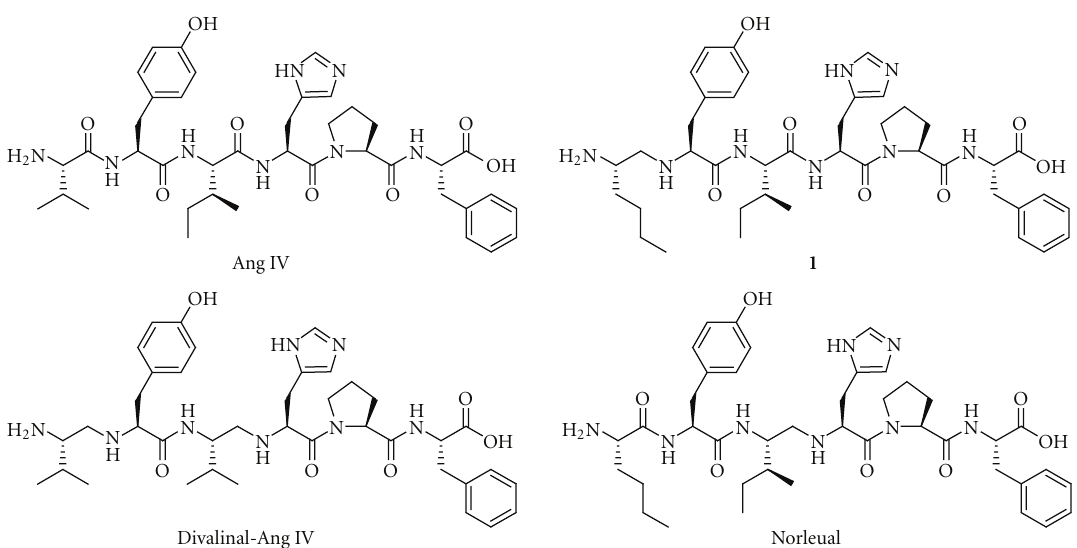
Figure 6: Ang IV and three hexapeptide analogues that incorporate one or two reduced peptide bonds ( Ψ [CH 2 NH]) as peptide bond